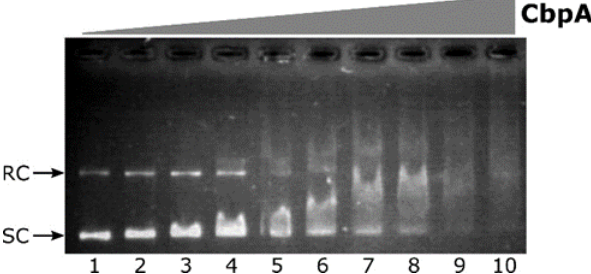
Figure 3. Electrophoretic mobility shift assay (EMSA) experiment with purified H. pylori CbpA on a plasmid DNA probe. The pHel2-flaAfur plasmid probe (7 fmol/rxn) was incubated with 0, 75, 110, 150, 190, 225, 265, 300, 340 and 375 nM of purified CbpA (lanes 1 to 10 , respectively) at 25 °C for 25 minutes before electrophoretic separation through 0.9% agarose gel. Symbols: SC, supercoiled plasmid DNA; RC, Relaxed Circular plasmid DNA.